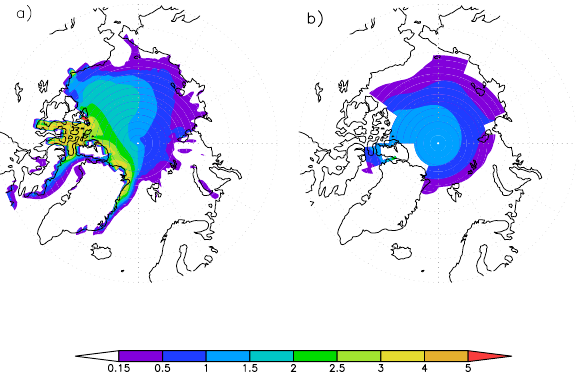
Fig. 11. Sea-ice thickness in the pre-industrial simulation for the minimum ice extent for (a) the HadGEM2-ES and (b) the MRIOC- ESM. Only ice thicker than 15cm is included in the